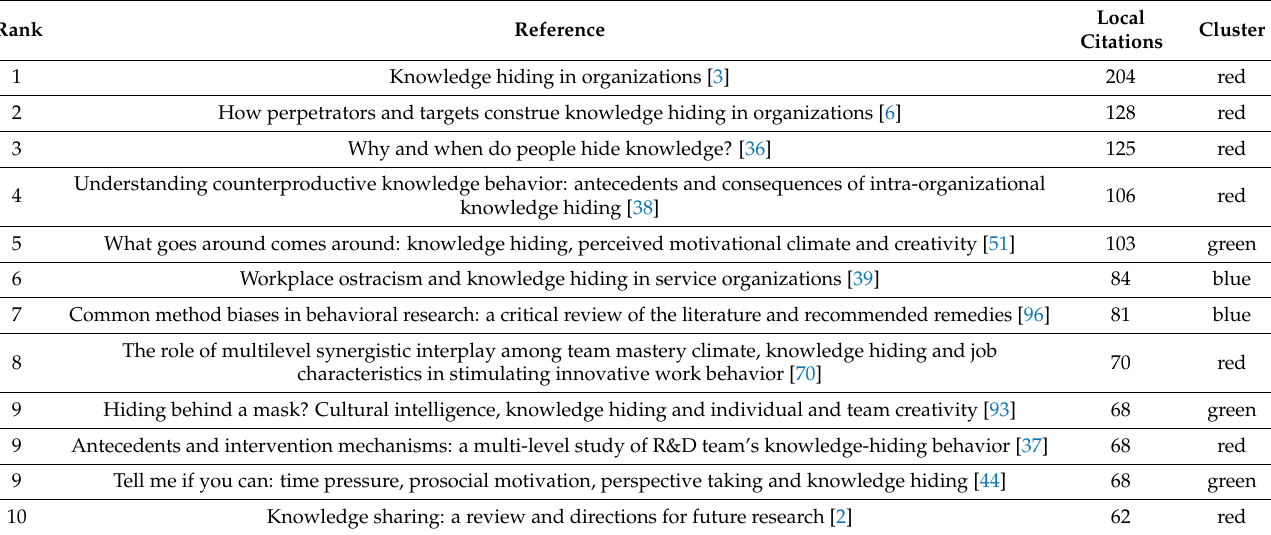
Table 6. Top 10 highly cited references in co-citation